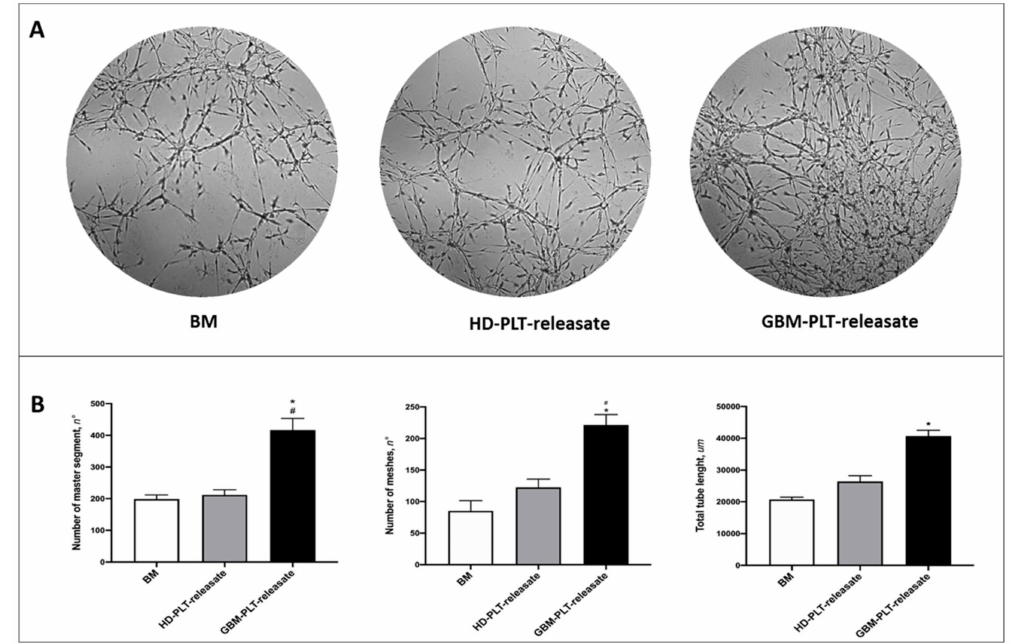
Figure 5. GBM-PLT-releasate strongly induced GBM endothelial cell (GEC) cord formation. ( A ) Representative images of GECs cultured for 24 h in Matrigel with PLT-releasate from HD- and GBM-PLTs for 24 h. ( B ) Quantification of number of master segment meshes and total tube length measured using the Angiogenesis Analyzer plugin in ImageJ. Data are the mean ± SD of at least 3 experiments in triplicate. * p < 0.05 versus basal medium (BM); # p < 0.05 versus